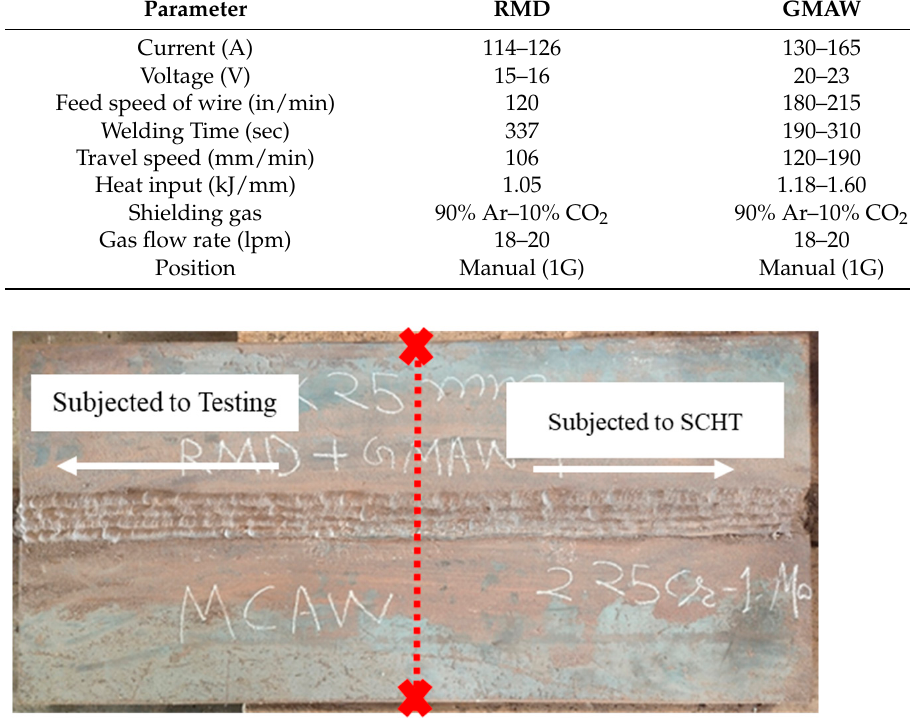
Figure 1. Weld configuration. Table 2. Welding parameters.